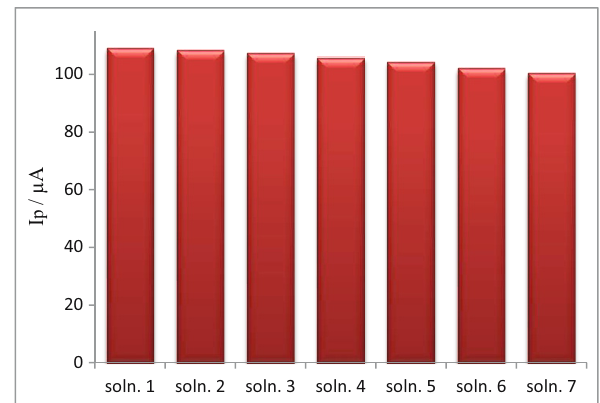
Figure 9: Repetitive measurements of the peak currents for seven solutions of 0.1 M PBS ( pH = 7.0 ) containing 0.5 mM of NPX at the poly ( r - o - NBA )